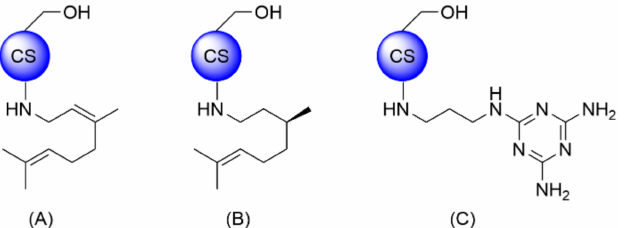
Figure 5. Different systems produced from CS alkylation: ( A ) COS-N-Ger, ( B ) COS-N-Cit, and ( C )